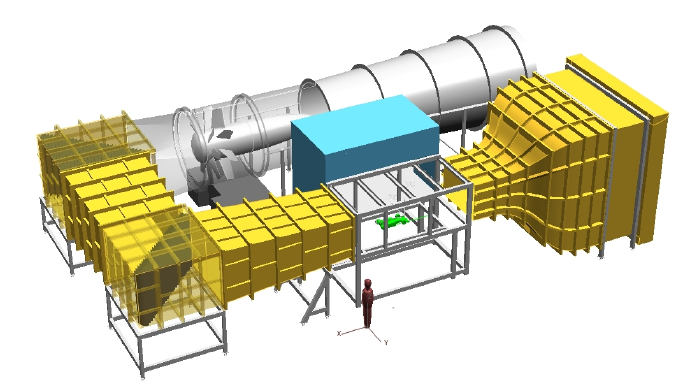
Figure 1. Loughborough University Large Wind Tunnel